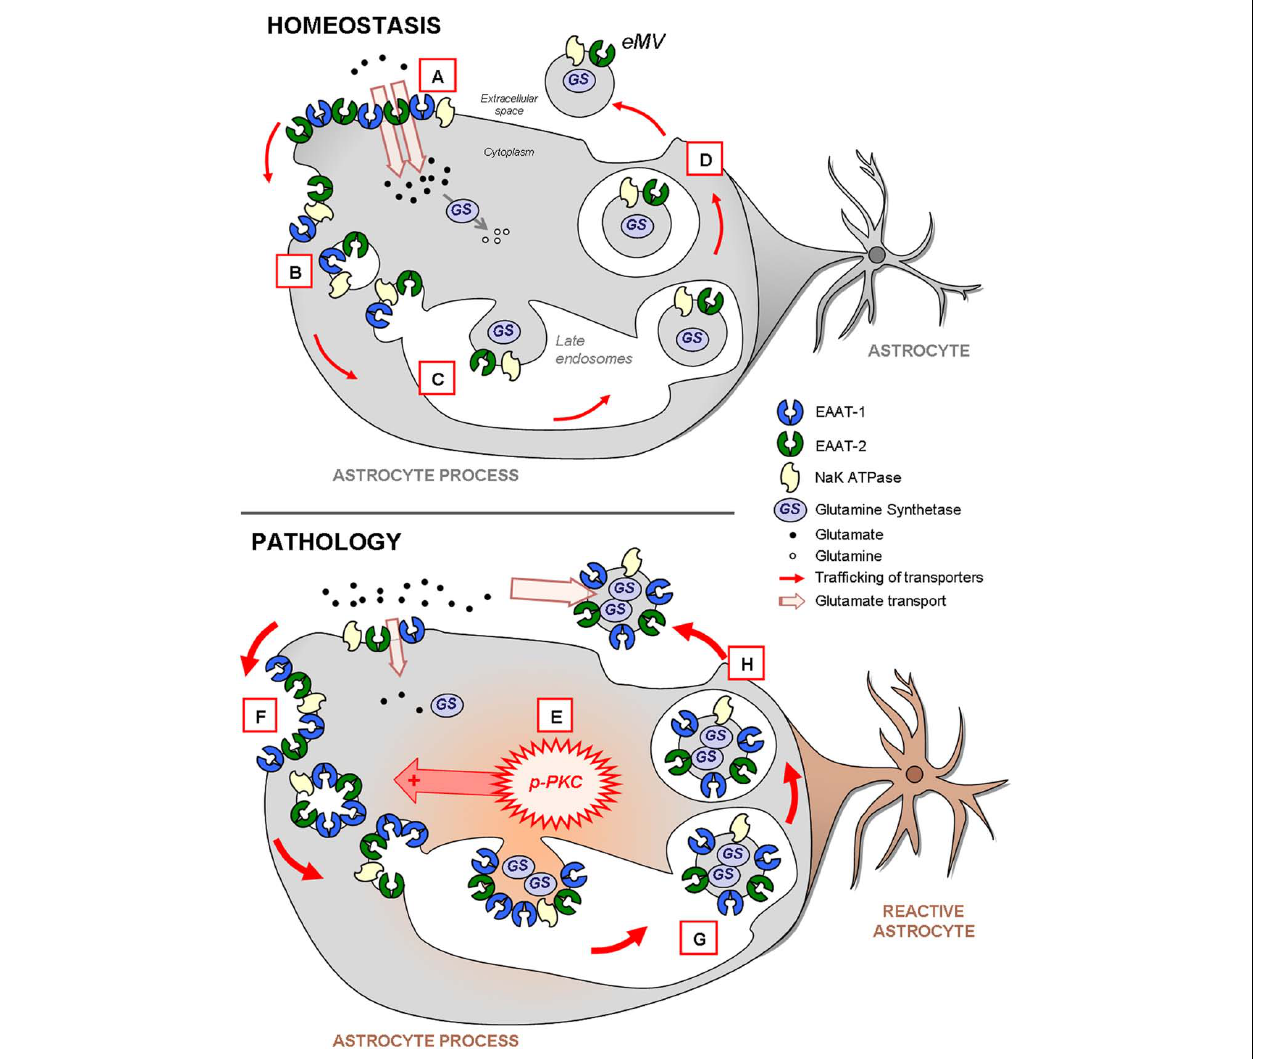
FIGURE 10 | Schema highlighting the trafficking of glutamate transporters in resting or reactive astrocytes. In homeostatic conditions (upper panel), both EAAT-1 and -2 are enriched at the plasma membrane providing an efficient glutamate reuptake ( A ; see Figures 2 and 7 ) as well as in intracellular early (B) or late (C) endosomal pools ( Figure 2 ). Furthermore, EAAT are also constitutively targeted to eMV ( D ; see Figure 3 ) together with glutamine synthetase and NaK ATPase, especially EAAT-2 in vivo (see Figure 9 ). During astrocytic reaction associated with pathological conditions (lower panel; see Figure 6 ) the activation of PKC ( E ; see Figure 2 ) and in particular PKC- δ (see Figures 3,5, and 6 )